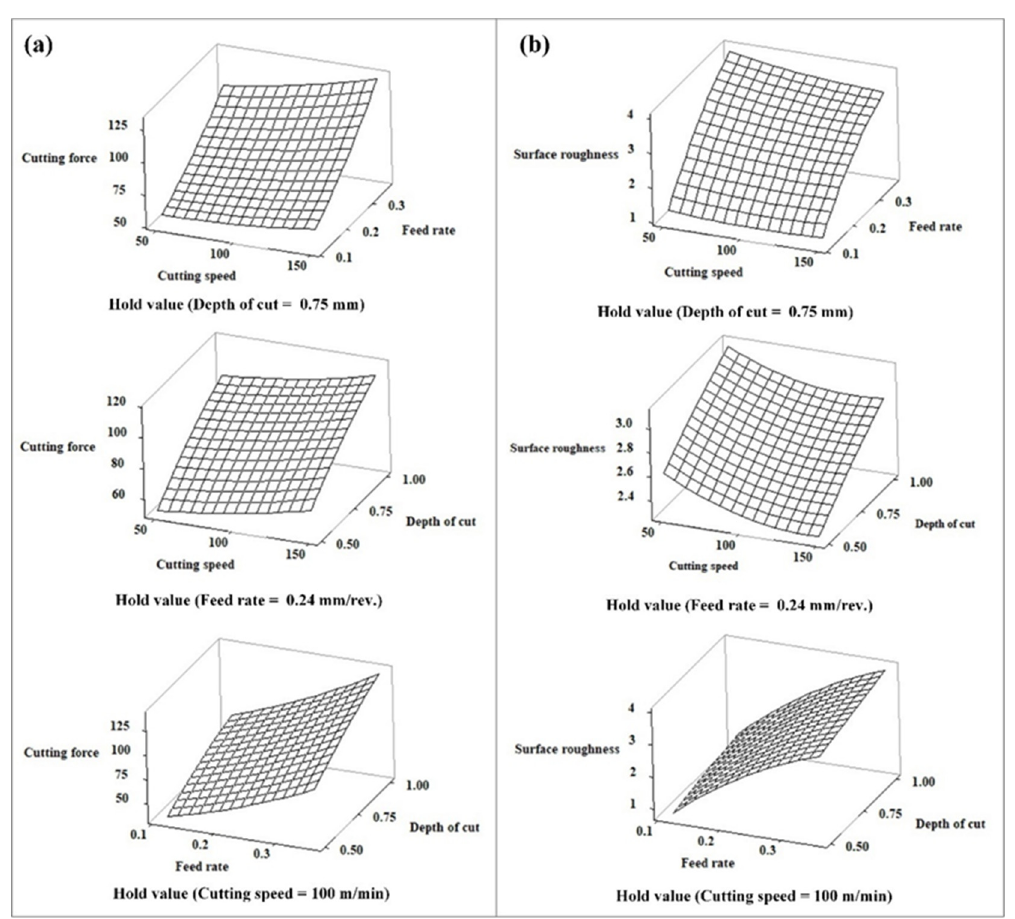
Figure 4. Response surface plots for ( a ) cutting force and ( b ) surface roughness of the RZ5/8 wt.% TiB 2 composite .